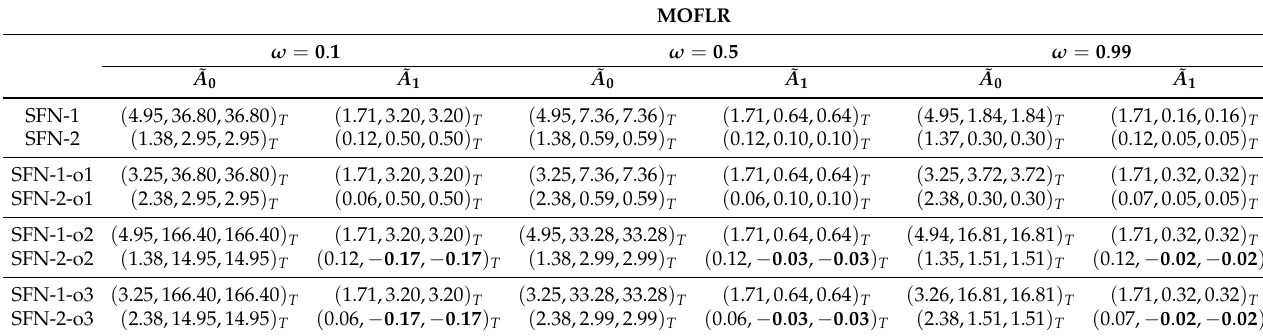
Table 6. Parameters of fuzzy regression models ˜ A 0 and ˜ A 1 estimated by the multi-objective fuzzy linear regression (MOFLR) on datasets (first column) with symmetric fuzzy observations. Settings of the adjustable parameter ω are stated in the second line. Negative spreads are in bold.